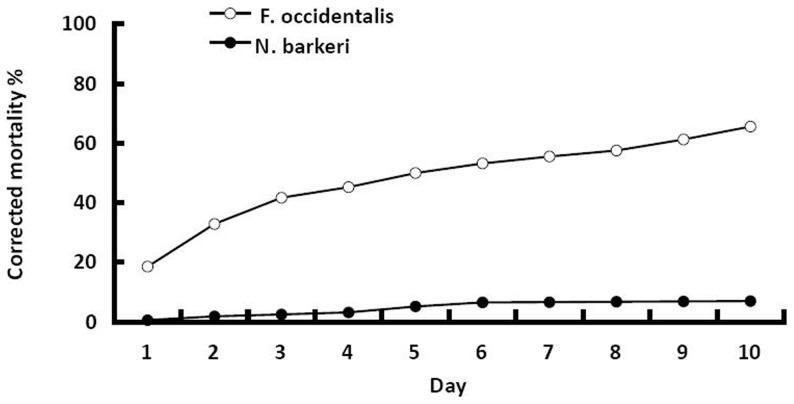
Corrected mortality of F. occidentalis and N. barkeri over 10 days following inoculation as first instars with 1×107 conidia mL1 of B. bassiana strain SZ-26.After 10 days, surviving F. occidentalis had reached the pupal stage and surviving N. barkeri had reached the adult stage.